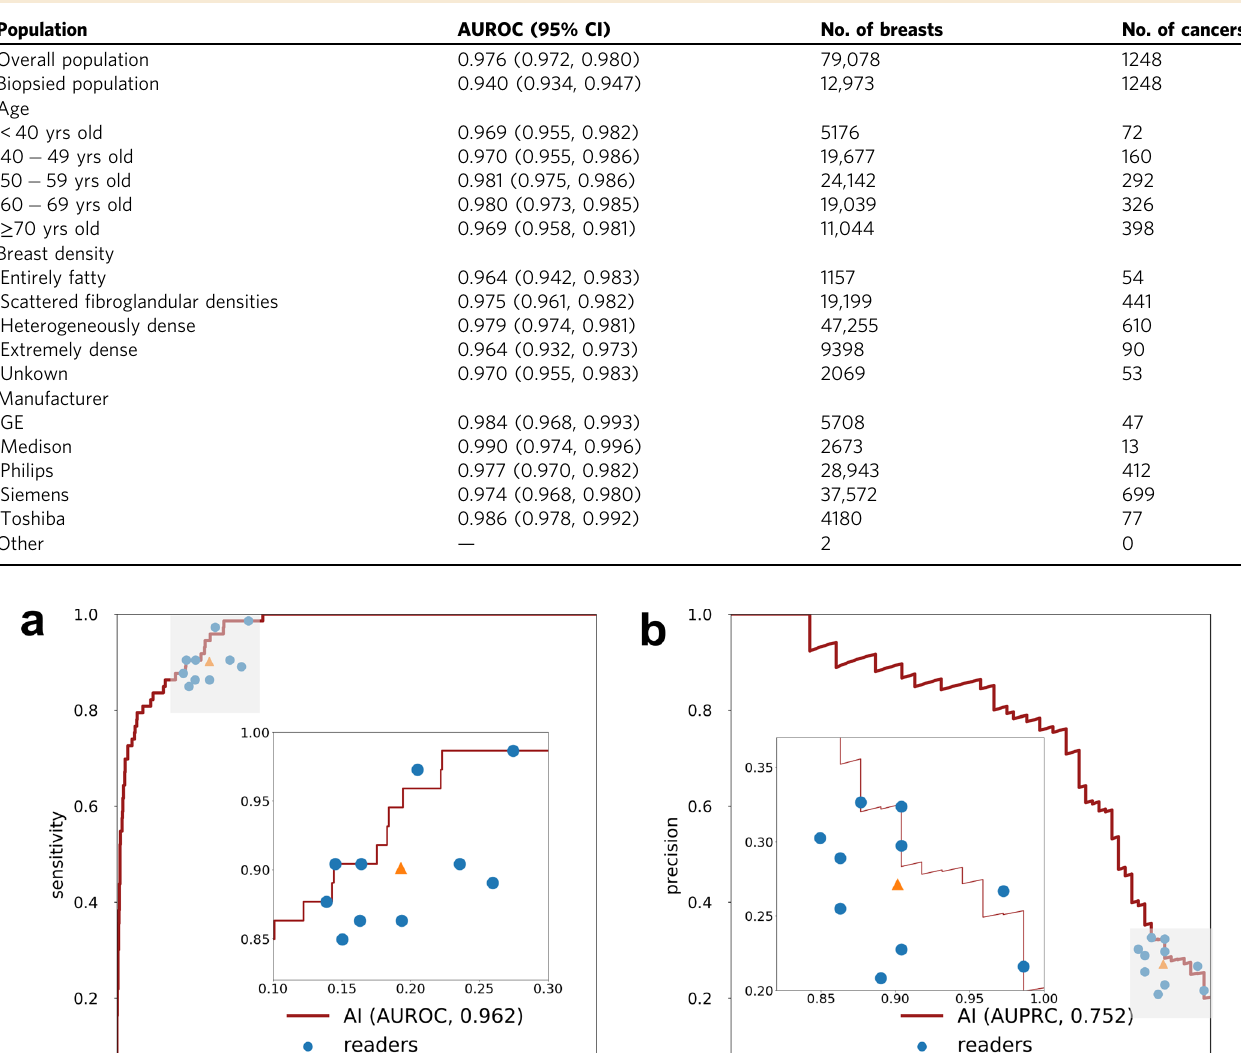
Table 2 AI performance on the internal test set across different sub-populations. We reported the AUROC of the AI system with 95% con fi dence intervals on the internal test set. The biopsied population only includes exams where at least one biopsy was recommended. We strati fi ed exams based on patient age, mammographic breast density, and the manufacturer of the US devices. Mammographic breast density was categorized based on the BI-RADS standards 69 .